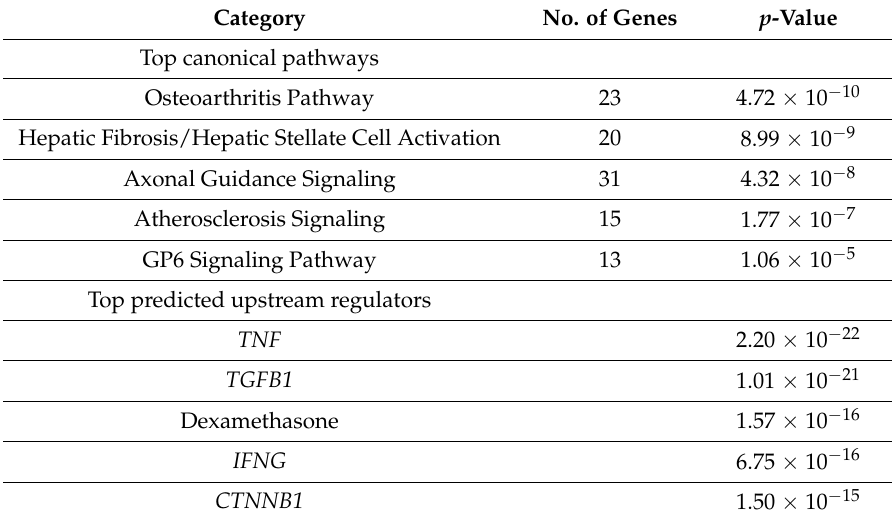
Table 1. Top canonical pathways and upstream regulators involved in differentially expressed genes of osteoarthritic (OA) knee chondrocytes.